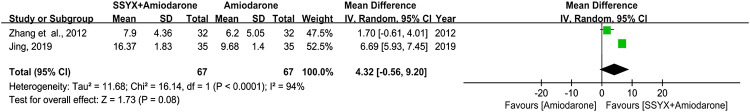
Forest plot of comparison: SSYX-amiodarone vs. amiodarone alone: LVEF.